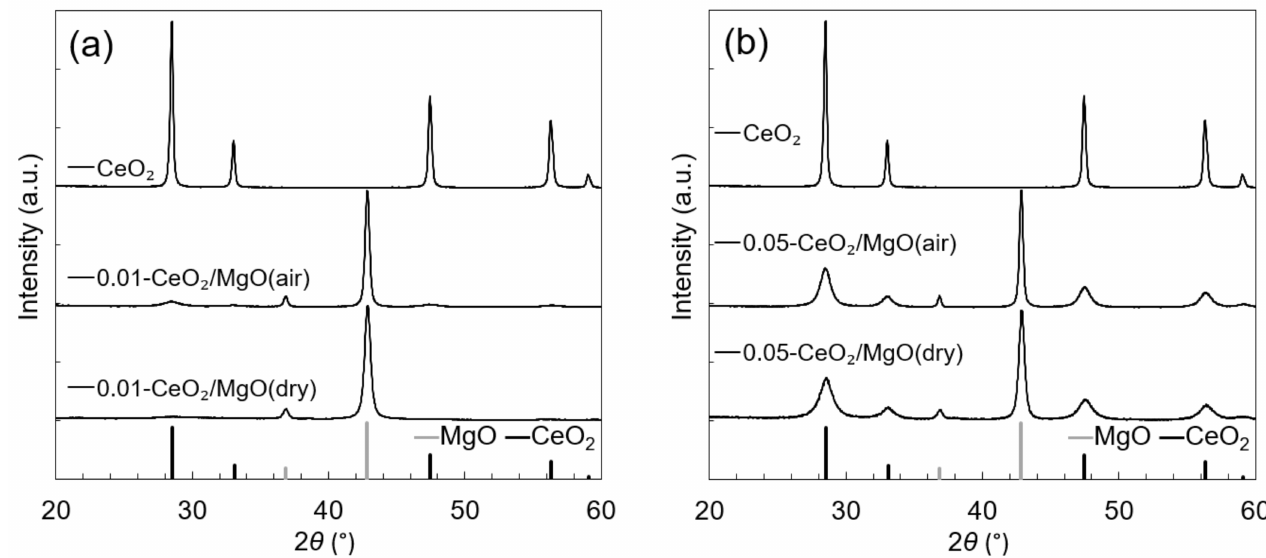
Figure 1. XRD patterns of ( a ) 0.01-CeO 2 /MgO and ( b ) 0.05-CeO 2 /MgO catalysts compared to that of pure CeO 2 . A Cu X-ray source and an Ni filter were used. MgO and CeO 2 patterns were assigned based on the references